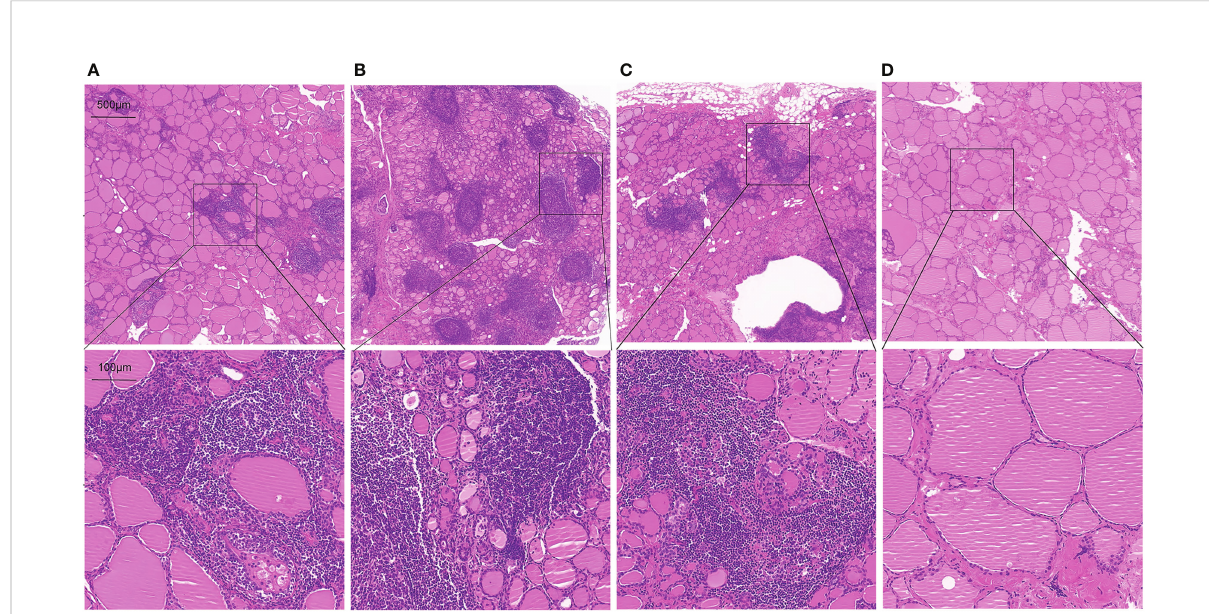
FIGURE 3 Representative HE staining images in thyroid tissue sections from AIT patients (up:20× magni fi cation, down:100× magni fi cation). (A) female, 49 years old, TPOAb < 28 U/ml, TGAb = 199.9 U/ml, T1 = 979. (B) female, 30 years old, TPOAb = 1934.5 U/ml, TGAb = 179.9 U/ml, T1 = 1060. (C) female, 49 years old, TPOAb < 28 U/ml, TGAb = 75 U/ml, T1 = 1006. (D) male, 52 years old, TPOAb = 33.8 U/ml, TGAb = 291.8 U/ml, T1 = 766.